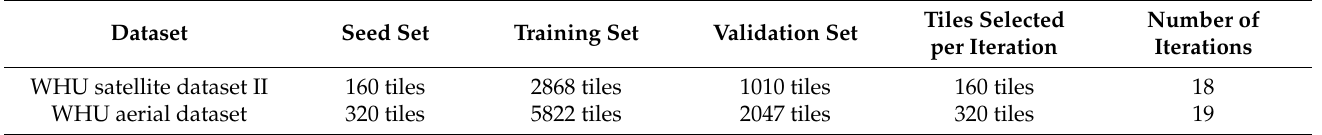
Table 2. The seed set, training set, and validation set of building datasets used in this study.